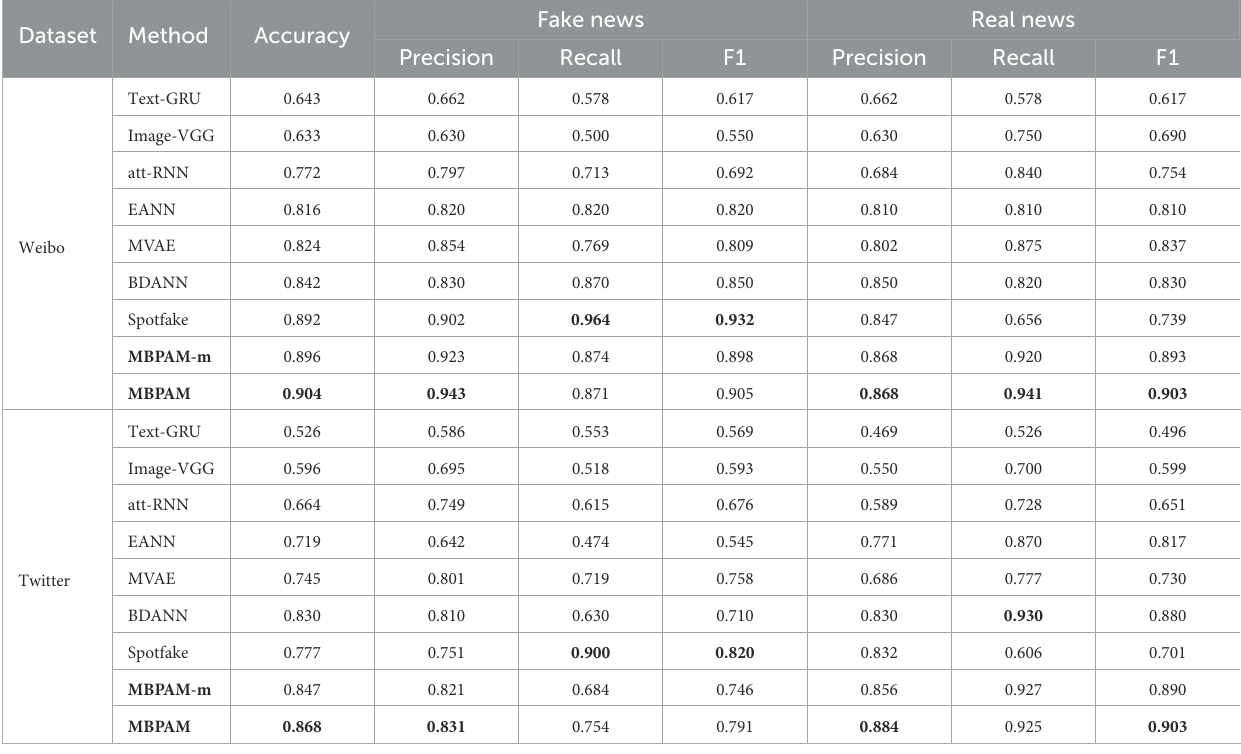
TABLE 2 Performance of MBPAM vs. other methods on Weibo and Twitter datasets.